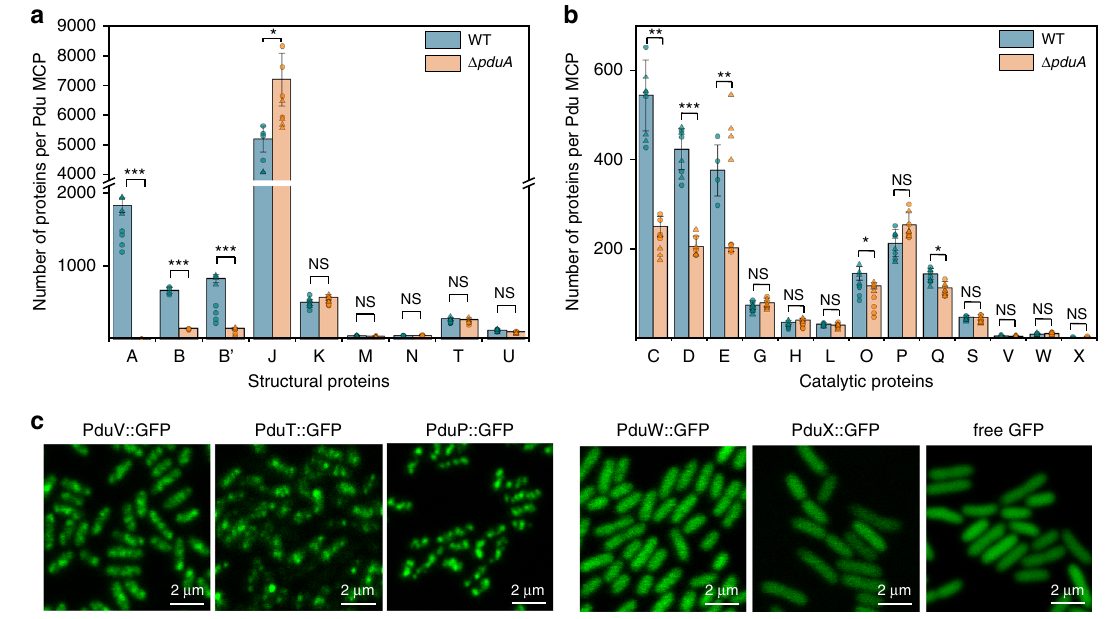
Fig. 3 Stoichiometry and localisation of Pdu proteins. a Gross number of the structural proteins per Pdu MCP. b Gross number of the catalytic proteins per Pdu MCP. Circle: signature peptide 1; triangle: signature peptide 2. The peptides with higher values were used for generating error bars (SD) and centre (mean), reasoning that signal loss from endogenous peptide is more likely. One peptide with higher values for PduE was excluded, because a time course digest revealed that slower digestion of this peptide could have led to overestimation. The stoichiometric data are shown in Table 1. The deletion of PduA resulted in signi fi cant changes in the abundance of shell proteins PduB, B ’ , and PduJ ( p = 7.110e − 7 , 2.022e − 8 , and 0.013, respectively, n = 4, two-sided t test) and interiors PduC, D, E, O, and Q ( p = 0.001, 0.0003, 0.002, 0.027, and 0.028, respectively, n = 4, two-sided t test). n number of biologically independent samples. ns, p > 0.05; * p < 0.05; ** p < 0.01; *** p < 0.001. c The subcellular distribution of PduV, PduW, and PduX in S . Typhimurium LT2. PduV, PduW, PduT, and PduP were fused with eGFP at their C-termini and recombined into the S . Typhimurium LT2 chromosome. The eGFP fused to the C-terminal of PduX and the native eGFP were plasmid encoded. The spotty distribution of PduV, similar to that observed for PduT and PduP, indicated that PduV is localised with the Pdu MCPs. In contrast, PduW and PduX were localised throughout the cytoplasm, comparable to native eGFP, and did not possess typical Pdu MCP distribution in vivo. Source data of Fig. 3a, b are provided as Source Data fi